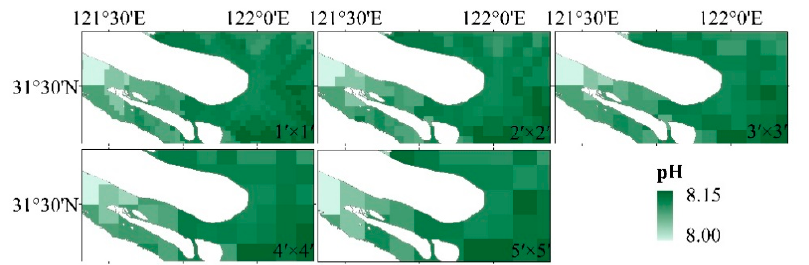
Figure 3. Spatial distribution of the pH at different spatial resolutions in the autumn of 2014 in the Changjiang River estuary.